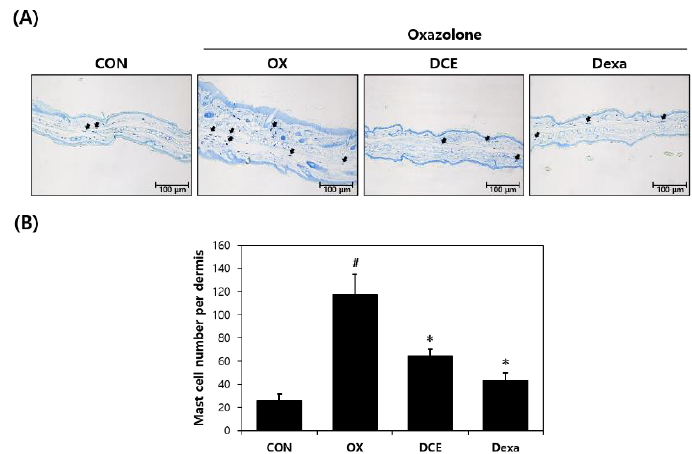
OX group: oxazolone-treated controls, DCE group: oxazolone plus 1% DCE-treated, and Dexa group: oxazolone plus 0.1% dexamethasone-treated. Data values are expressed as the means ±